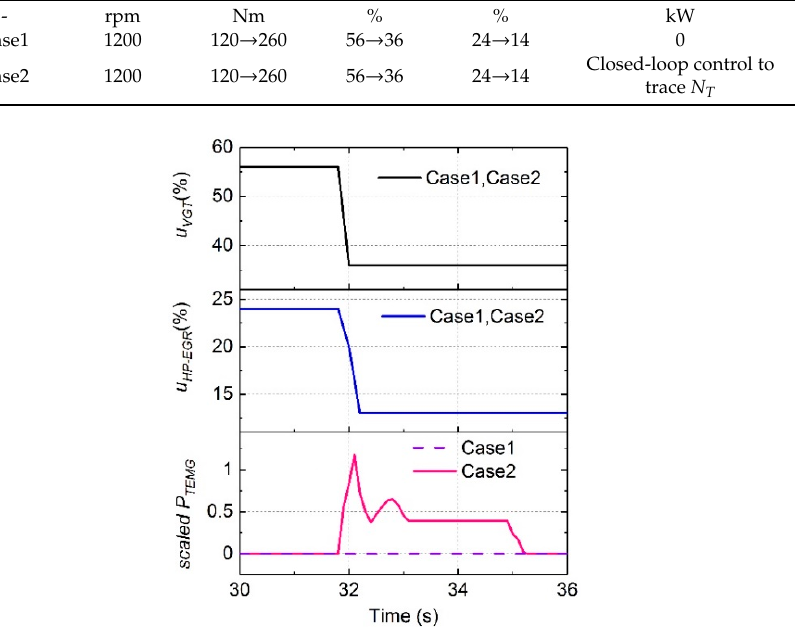
Figure 9. Regulations of three actuators during the transient process.